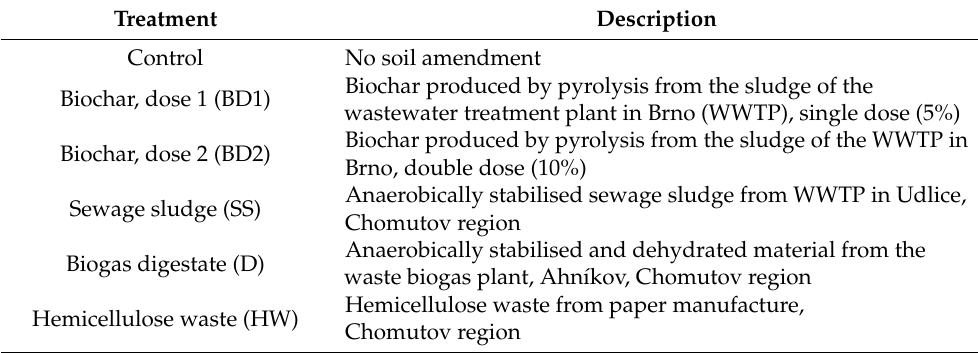
Table 1. Characteristics of the soil amendments utilized during establishing of M × g plantation on the marginal land.